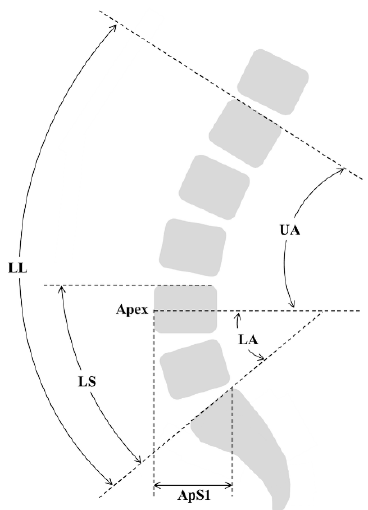
Figure 1. Parameters for evaluating postoperative lordosis morphology. LL, lumbar lordosis; LS, lumbosacral angle; UA; upper lordosis arc angle; LA, lower lordosis arc angle; Apex; lordosis apex, ApS1; horizontal distance from the anterior-most margin of the apex vertebra to the posterior margin of the S1 endplate.